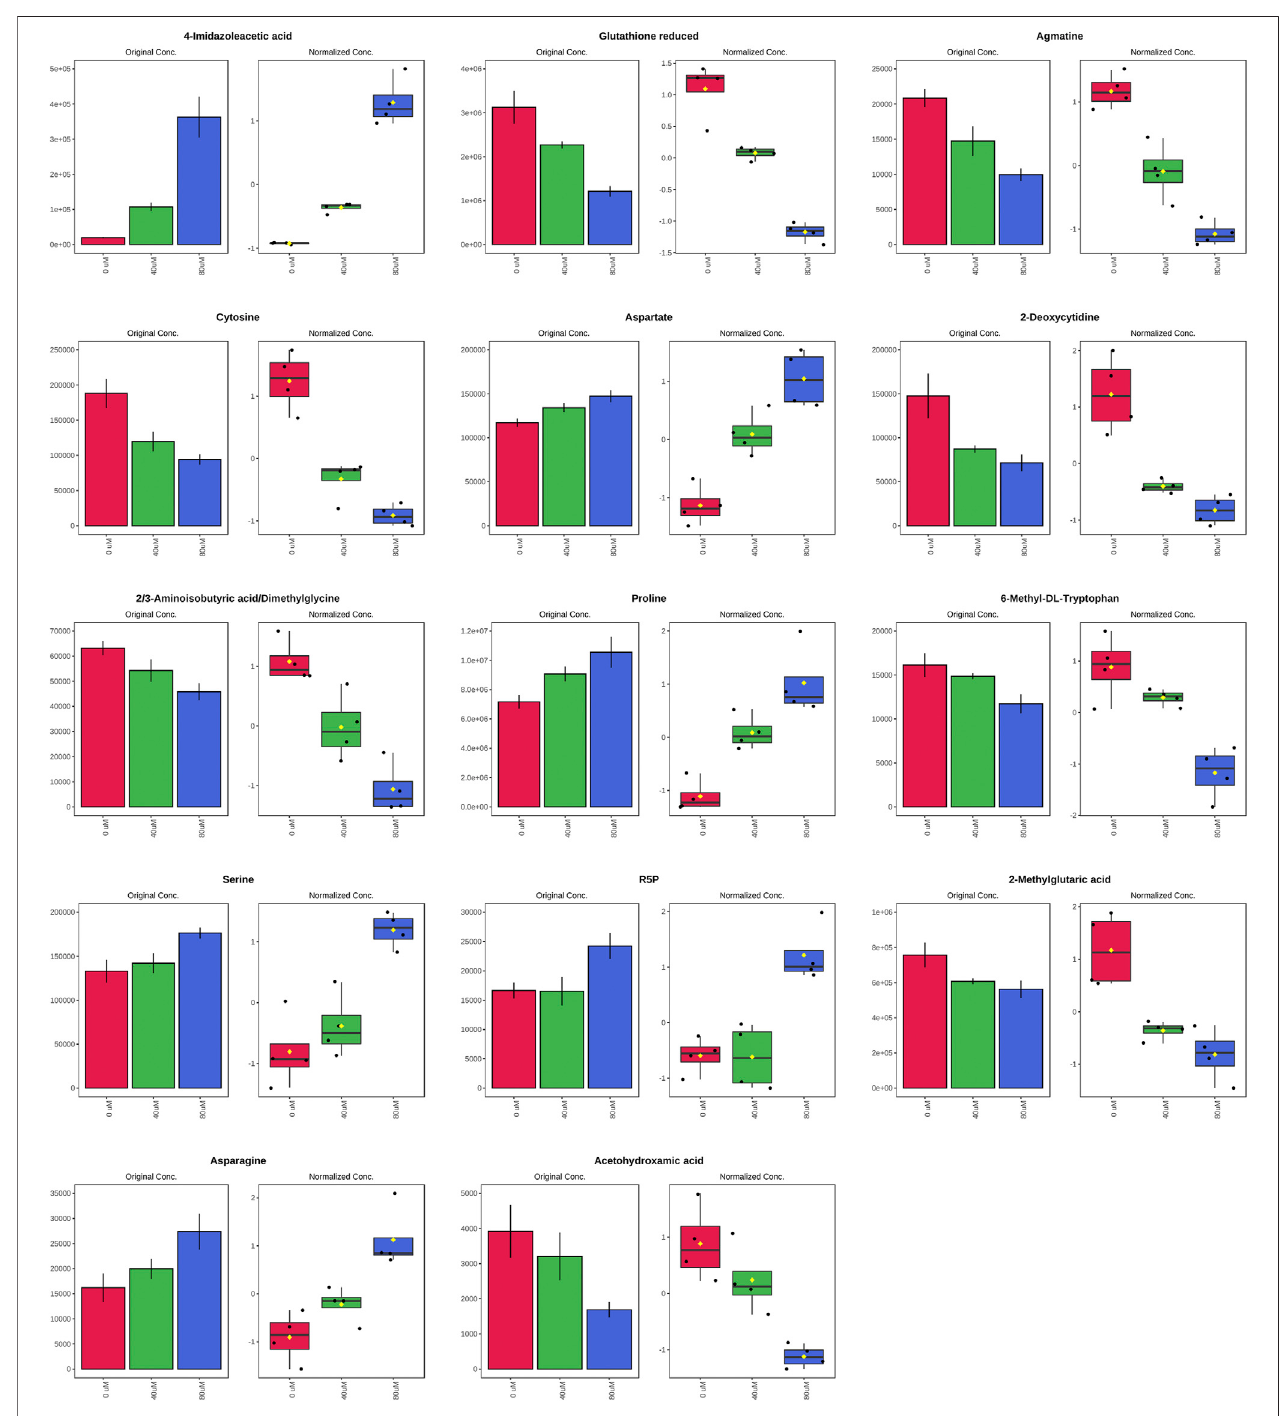
FIGURE 4 | Signi fi cantly altered metabolites among the control and the EGCG-treated groups. The bar plots on the left show the original peak intensity values (mean ± SD). The box and whisker plots on the right summarize the normalized values.